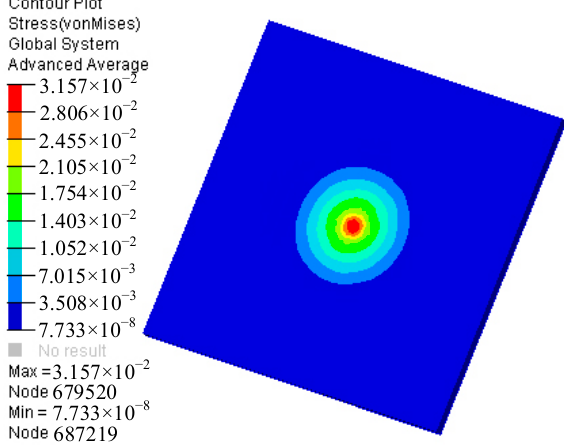
Figure 4. Finite element model of the MEMS S&A device under the denotation field.